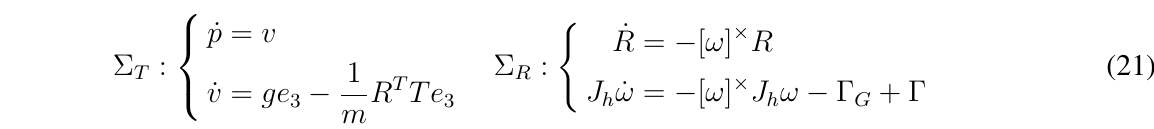
, (cid:126)e f , (cid:126)e f ] and body-fixed frame E b = [ (cid:126)e b 1 2 3